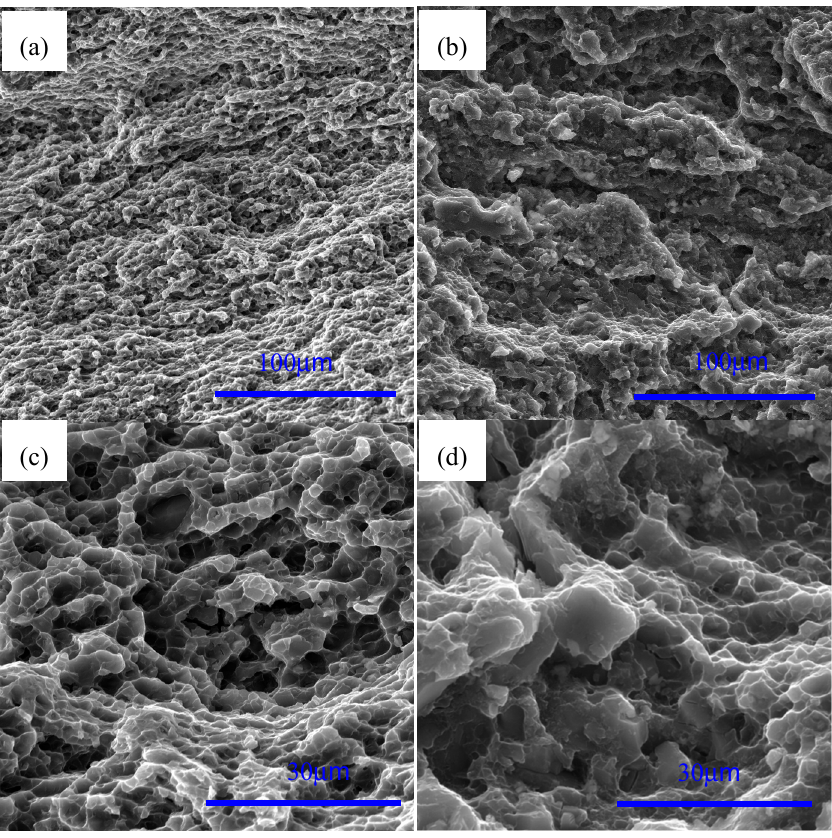
Figure 9. SEM images of fracture surface after multi-pass forging for 12 passes: ( a )( c ) AZ91 alloy and ( b )( d ) nano-SiCp/AZ91 composites.